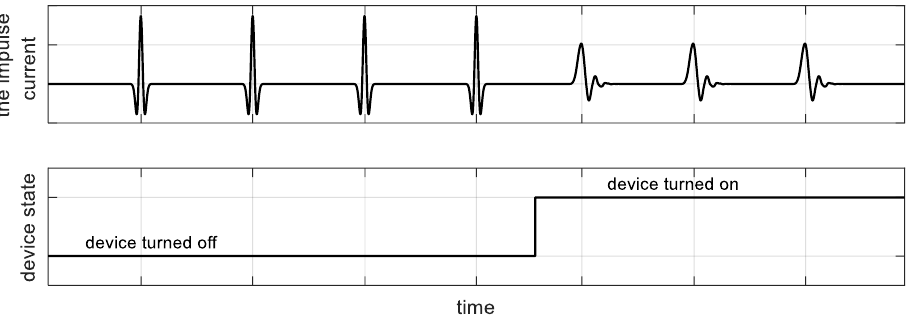
Figure 1. Illustration of the HF-GEN method.